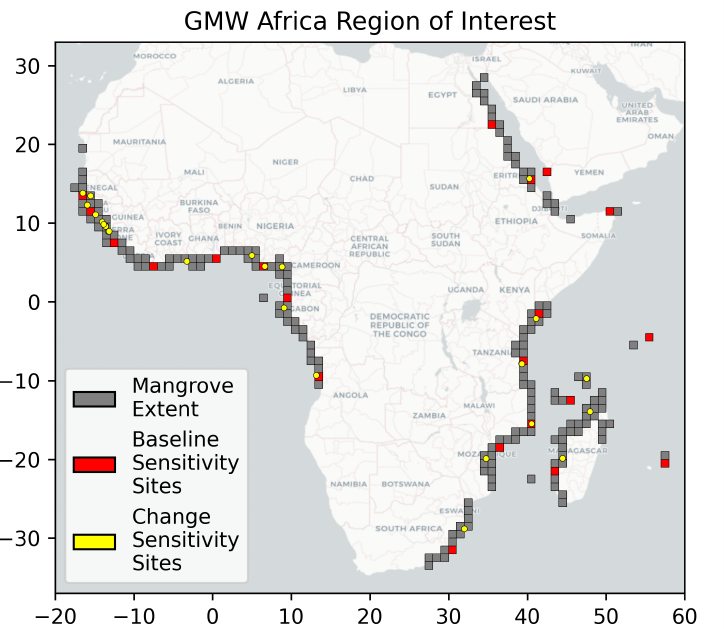
Figure 1. The regions of interest for Africa are defined by the 1 × 1 degree tiles intersecting with the mangrove regions across Africa, as defined by the GMW v3.0 2018 mangrove extent map. The figure also shows the locations of the sites used to optimise the parameters for the baseline refinement (Red) and change detection threshold